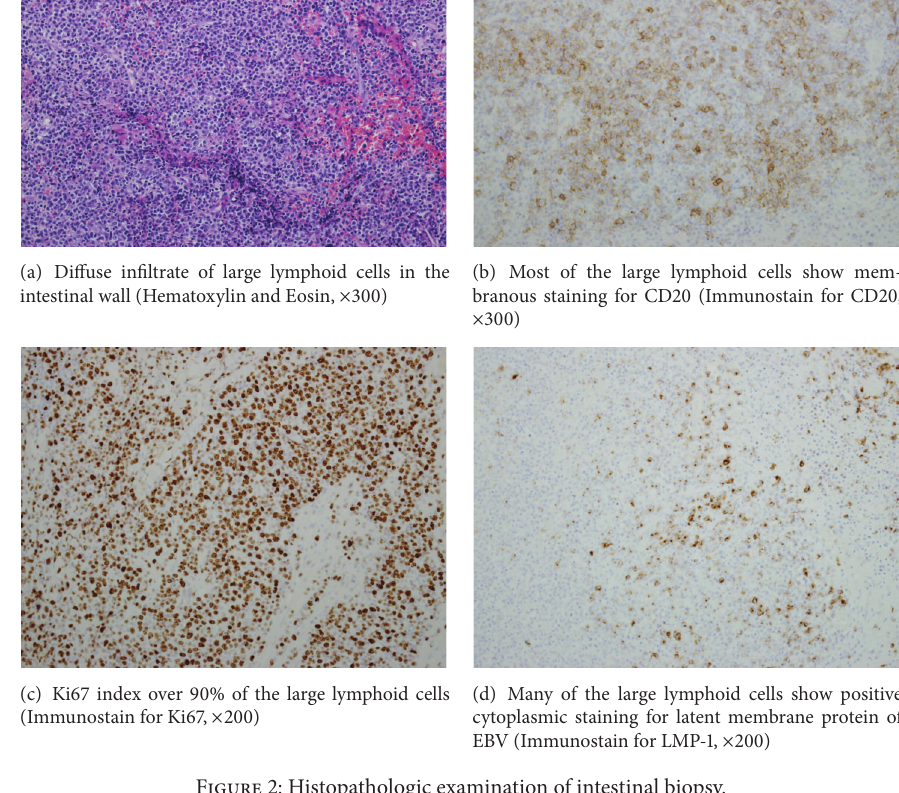
Figure 2: Histopathologic examination of intestinal